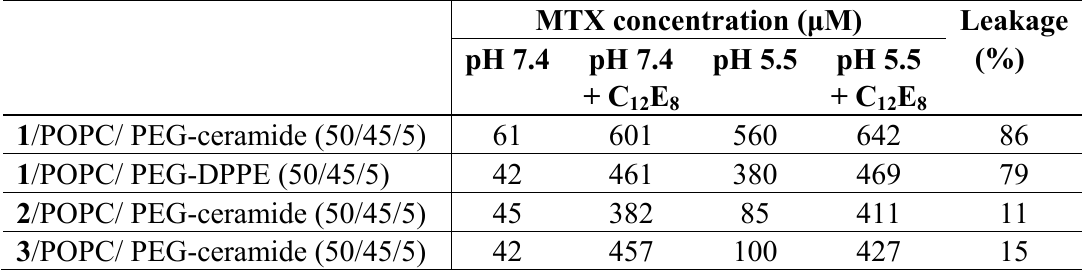
Table 3. pH-Triggered release of methotrexate from PEGylated